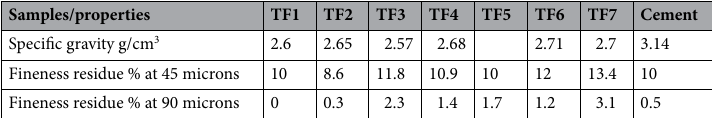
Table 9. Physical properties of ground of each of volcanic tuff and cement.